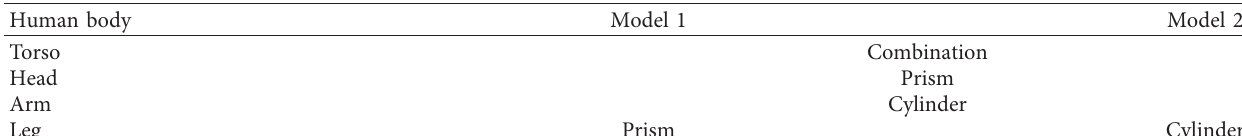
Table 14: Human body models with various leg shapes.